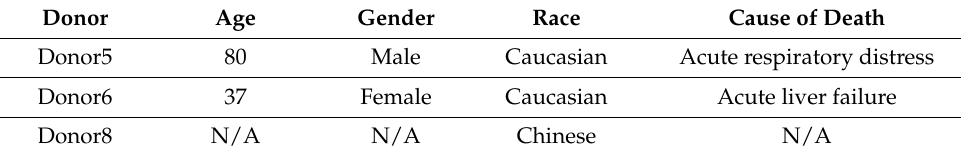
Table 1. Human donor demographic characteristics. N/A = not